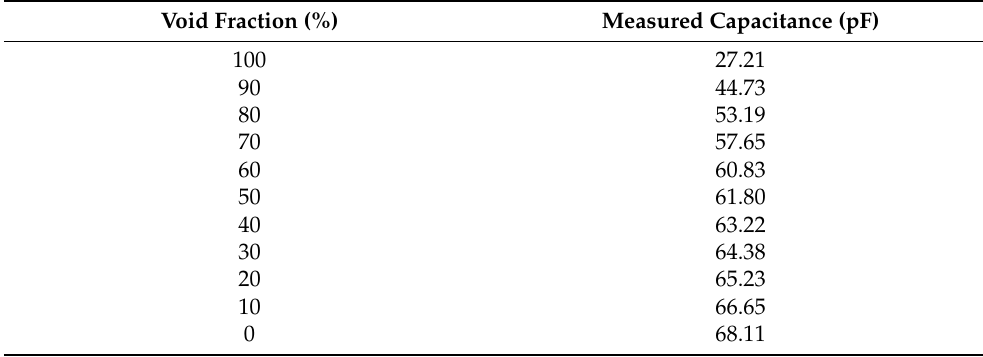
Table 1. Measured results by the experimental setup for the concave sensor in the annular water–air regime.